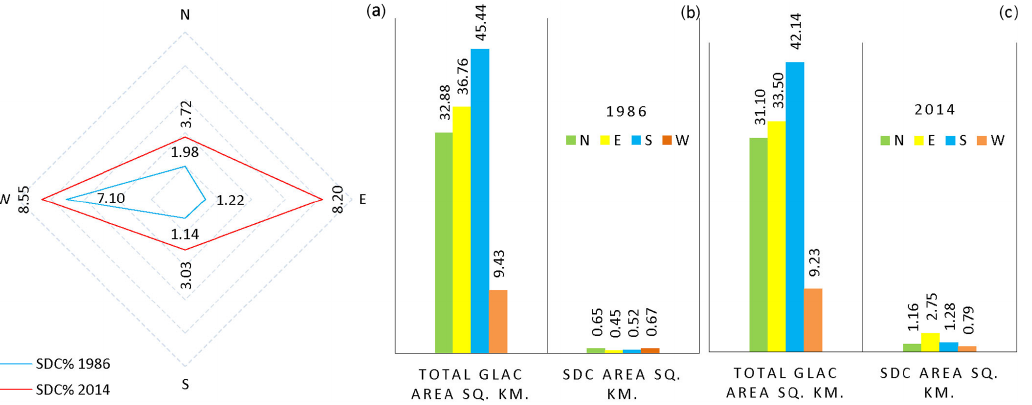
Figure 5. Percentage of supra-glacial debris cover (SDC) for the Elbrus slopes in 1986 and 2014 (a) . Total glacier area (km 2 ) and supra- glacial debris-covered area changes (km 2 ) in 1986 (b) and 2014 (c) for the Elbrus slopes.